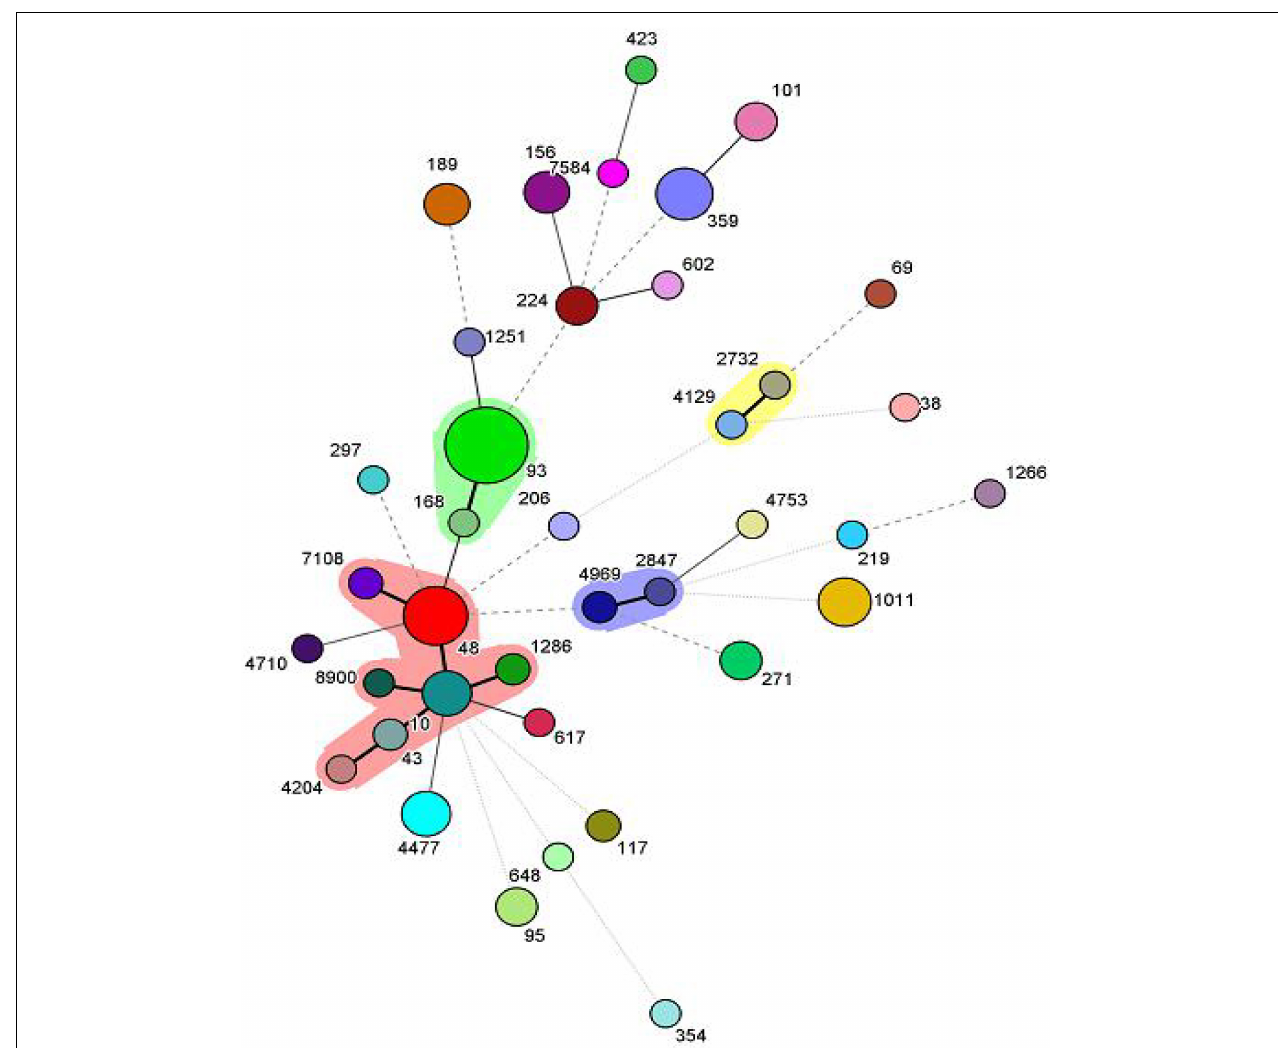
FIGURE 1 | Minimum-spanning tree analysis of the 102 mcr -1 positive isolates. Each circle represents one ST, and the area of the circle corresponds to the number of isolates, the shadow region indicates that ST2732 and ST4129 belonged to one clone complex, ST2847 and ST4969 belonged to one clone complex, ST7108, ST48, ST1286, ST10, ST43, ST4204, and ST8900 belonged to one